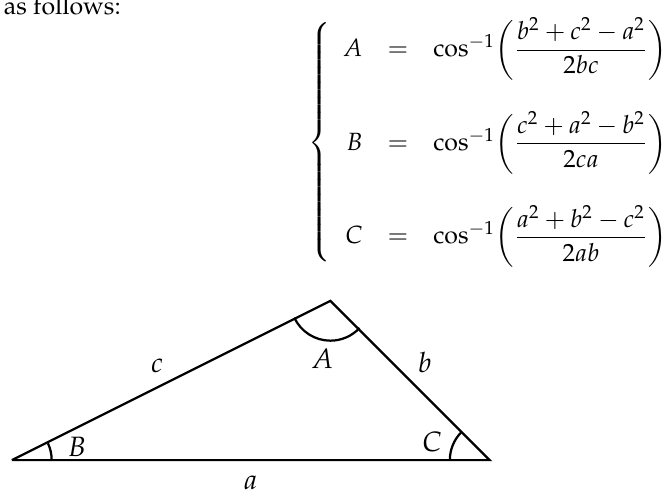
Figure A2. Angles and sides of a triangle Figure A1. Problem statement